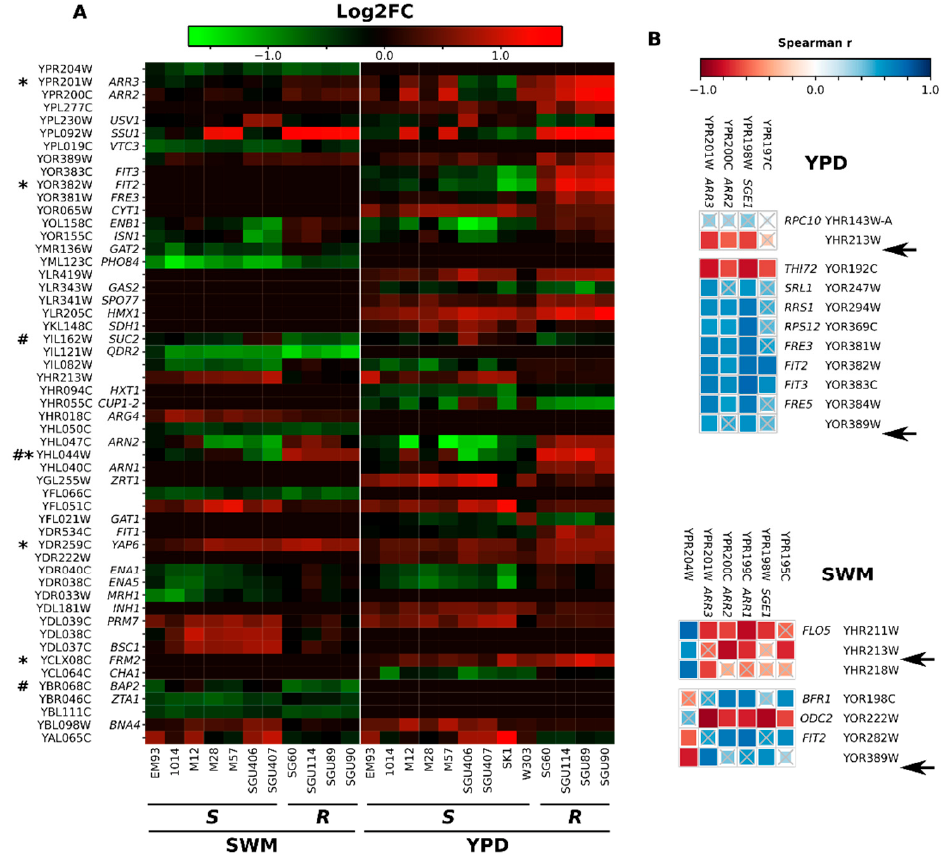
Figure 3. Transcriptomic analysis on strains resistant and sensitive to arsenic. ( A ) Heatmap reporting the expression levels of genes expressed at significantly different levels among resistant and sensitive strains. * and # represent genes differentially expressed in opposite directions (over vs. underexpressed and vice versa) in resistant compared to sensitive strains in YPD and SWM, respectively. ( B ) Spearman correlation analysis among expression levels of DEGs located in the ARR cluster and in the genomic regions, including the additional copies of the cluster (genes with names starting with “YH” are located in chromosome VIII, while those starting with “YO” are located in chromosome XV). For each comparison, the size and color of the squares indicate the calculated Spearman r. Crossed squares indicate not significantly correlated couples (fdr > 0.05). Black arrows indicate the position of the insertion of the additional copy of the ARR gene cluster in arsenic-resistant strains.